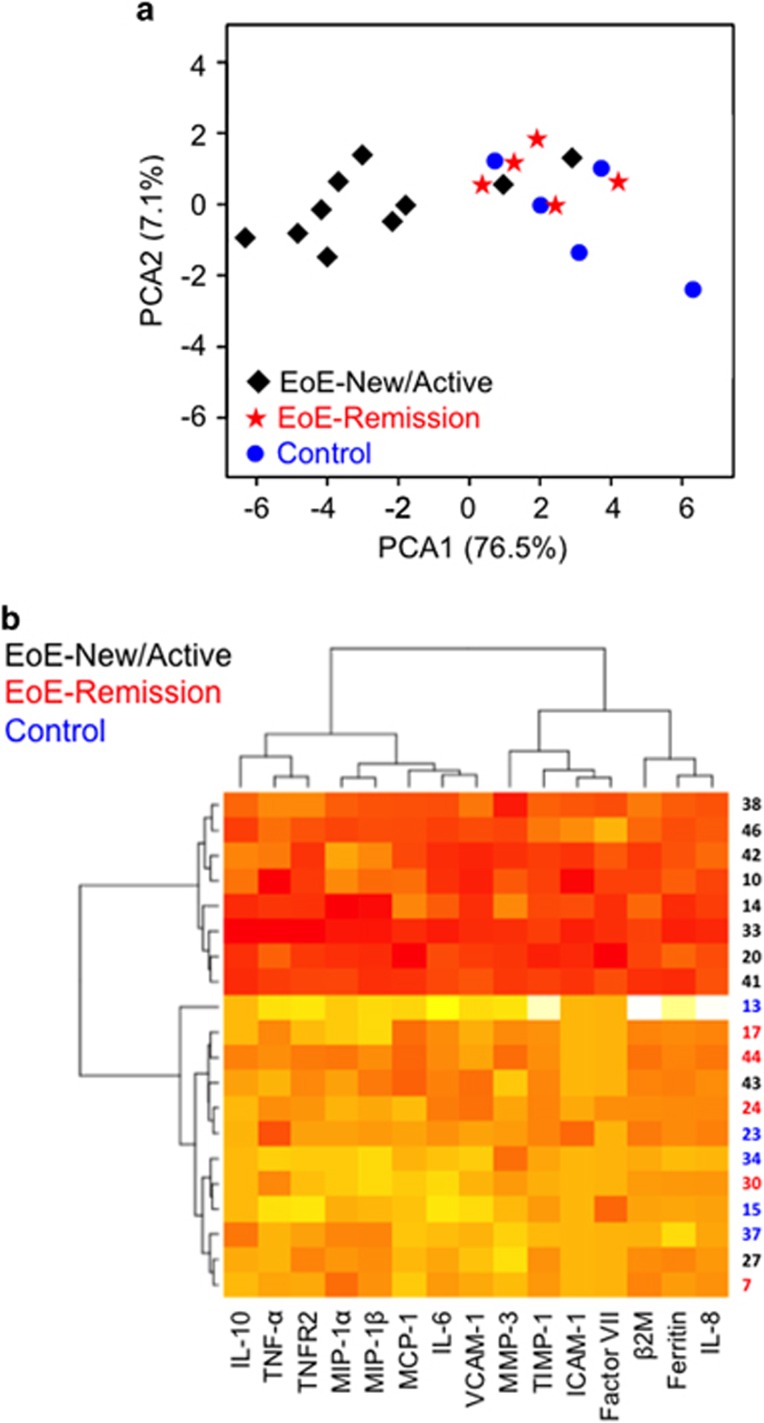
Patient group separation based on the cytokine network. (a) Unsupervised PCA of EoE-New/Active, EoE-Remission and Controls based on multiplex cytokine analysis from 72 h culture of esophageal biopsies. Two-dimensional PCA mapping represented 83% of variance (PC1=76% and PC2=7%). Each number represents a patient and patient groups are color-coded. (b) Unsupervised cluster analysis using cytokine levels between patient groups. Individual squares represent the cytokine concentration for the given cytokine (column) in a patient (row), with orange indicating higher cytokine levels and yellow indicating lower cytokine levels.